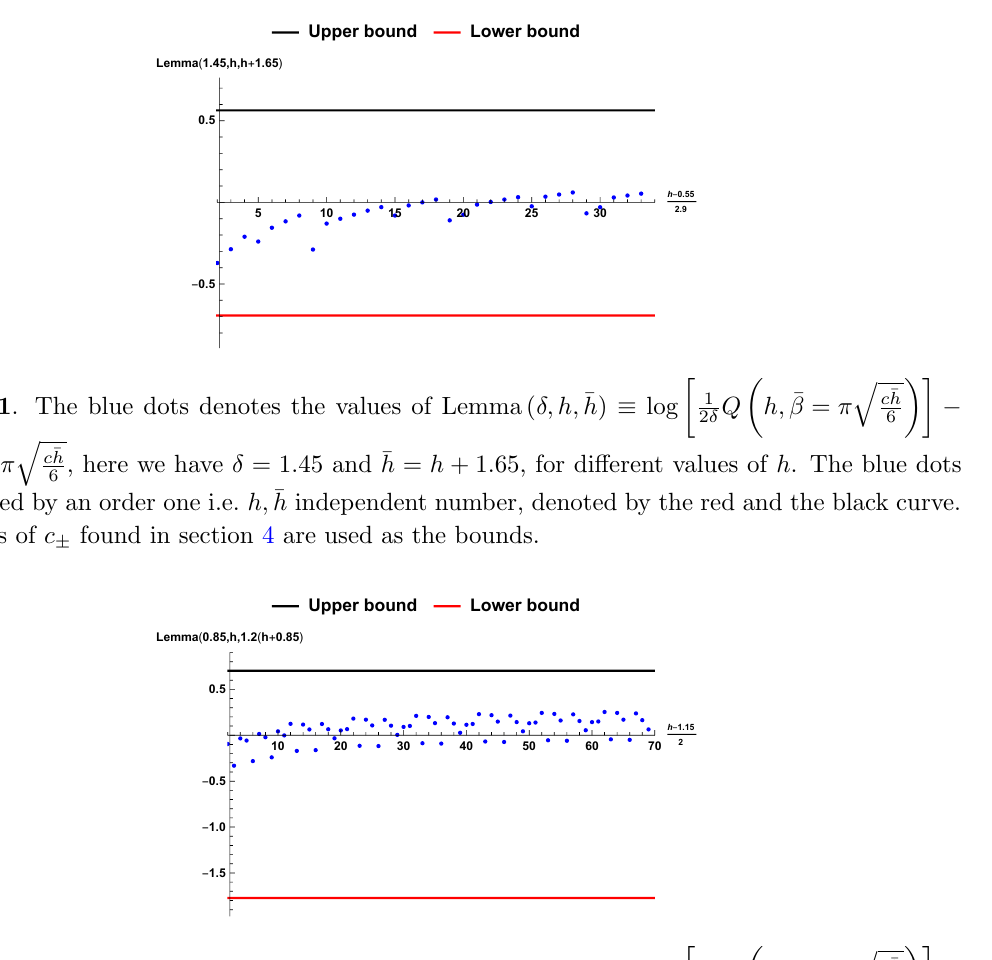
Figure 12 . The blue dots denotes the values of Lemma ( (cid:14); h; (cid:22) h ) (cid:17) log q q ch c (cid:22) h 2 (cid:25) (cid:0) (cid:25) , where (cid:14) = 1 : 7 and (cid:22) h = 1 : 2( h + 0 : 85), for di(cid:11)erent values of h . The blue dots are 6 6 bounded by an order one i.e. h; (cid:22) h independent number, denoted by the red and the black curve. The c (cid:6) found in the section 4 are used as the